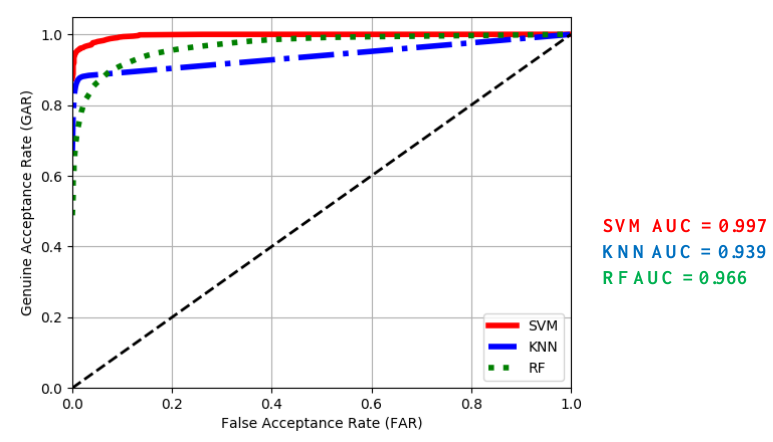
Figure 18. ROC curves of our proposed model for the IITD touchless